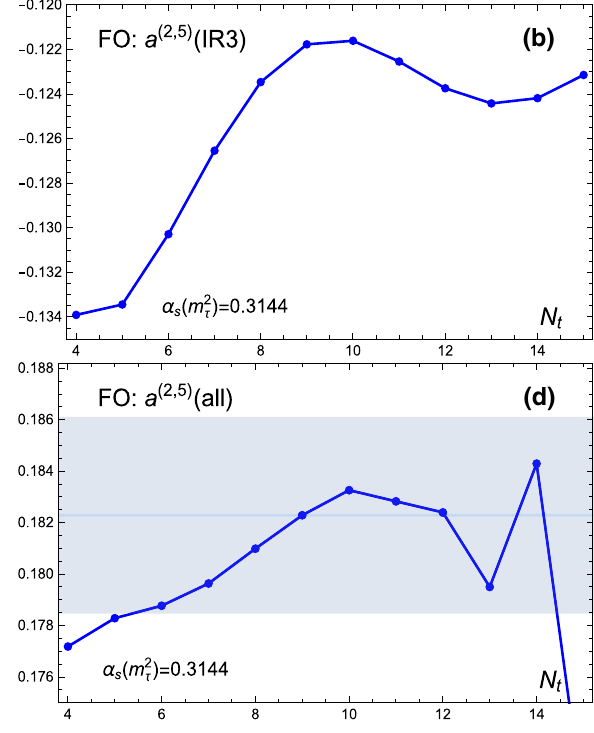
Fig. 3 The various contributions to the FESR moment a ( 2 , 5 ) (σ m ) in the FOPT (’FO’) approach, as a function of the truncation index N t , for α ( m 2 ) = 0 . 3144 (and κ = 1): a the contribution from the u = 2 IR τ s renormalon part of the Adler function; b from the u = 3 IR renormalon